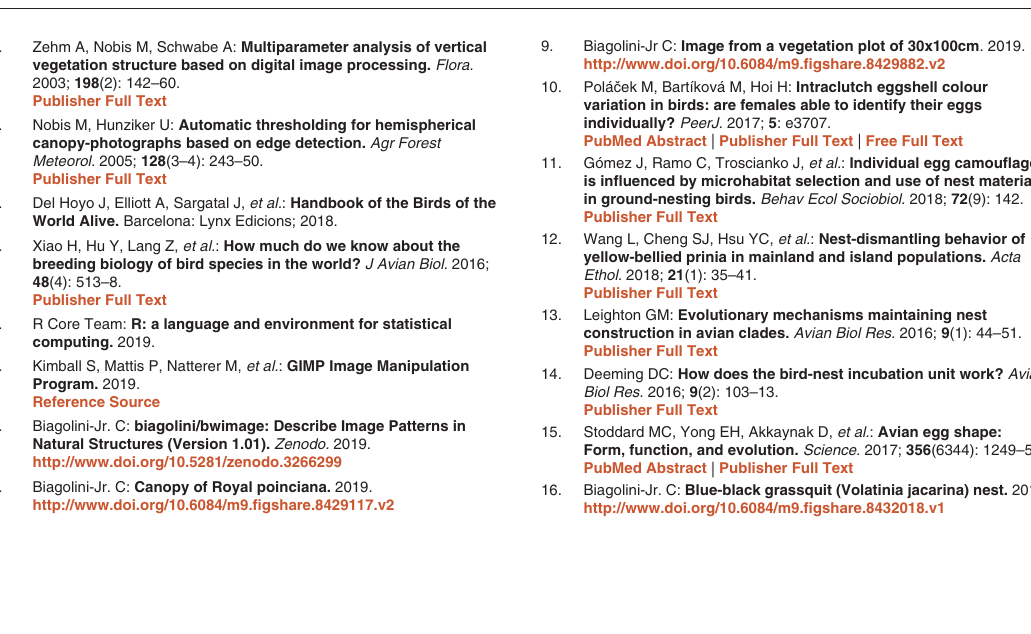
Figshare: Canopy of Royal poinciana. https://doi.org/10.6084/m9.figshare.8429117.v2 8